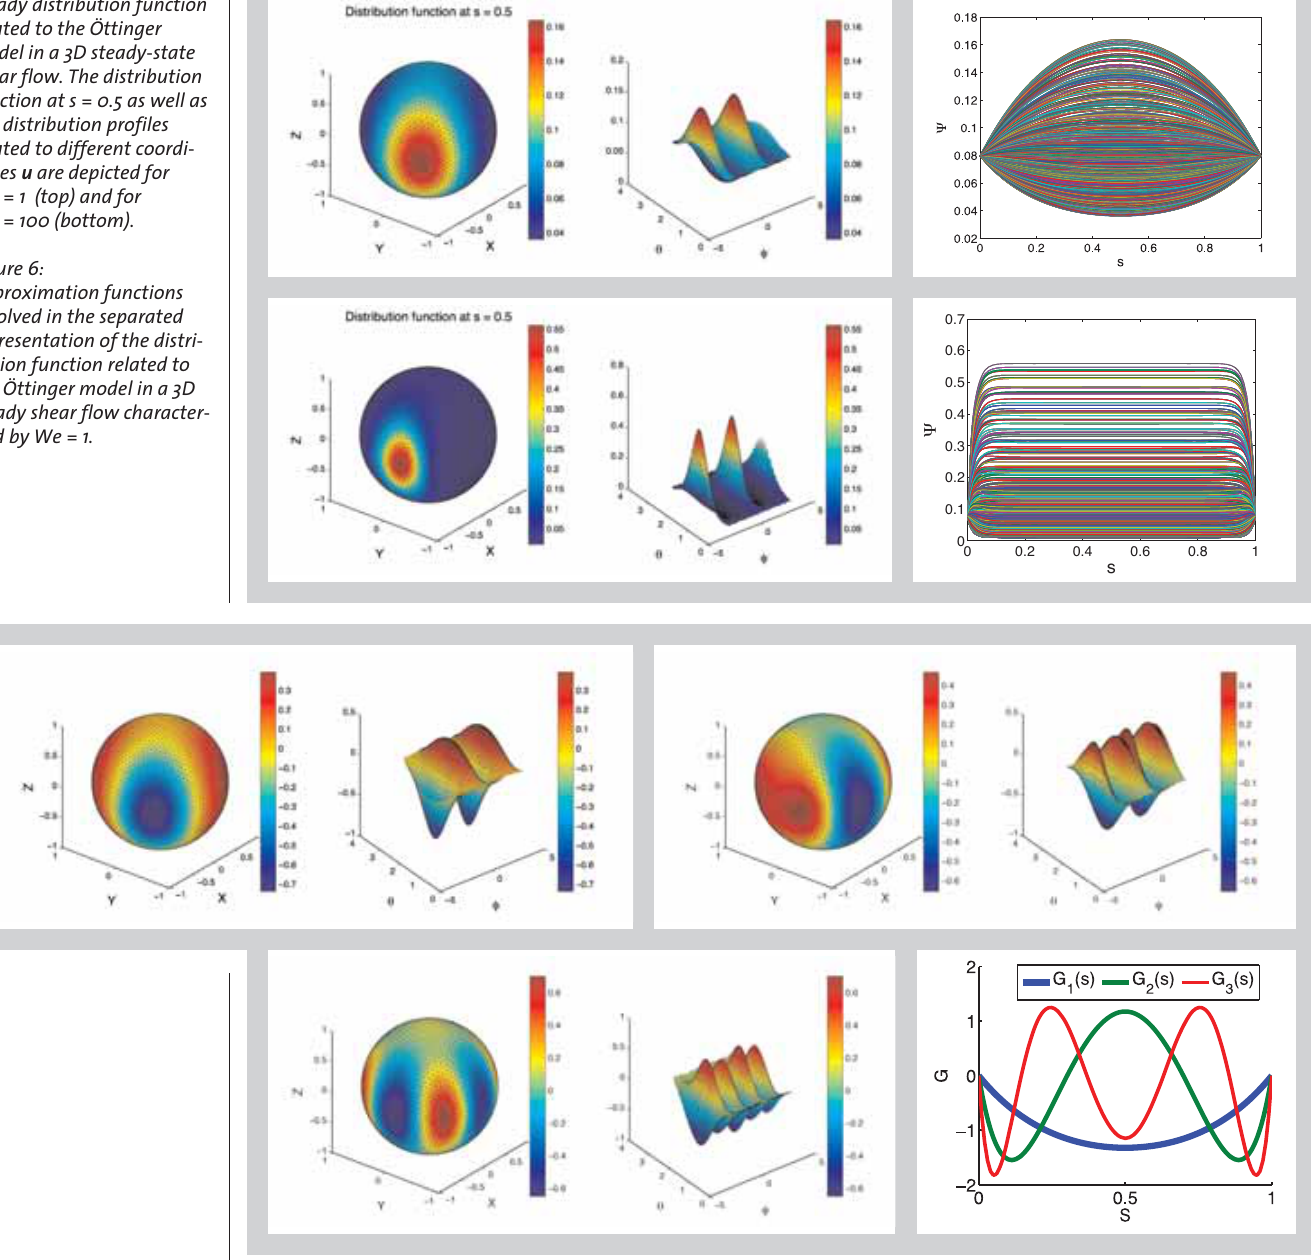
Figure 5 (above): Steady distribution function related to the Öttinger model in a 3D steady-state shear flow. The distribution function at s = 0.5 as well as the distribution profiles related to different coordi- nates u are depicted for We = 1 (top) and for We = 100 (bottom). Figure 6: Approximation functions involved in the separated representation of the distri- bution function related to the Öttinger model in a 3D steady shear flow character- ized by We =